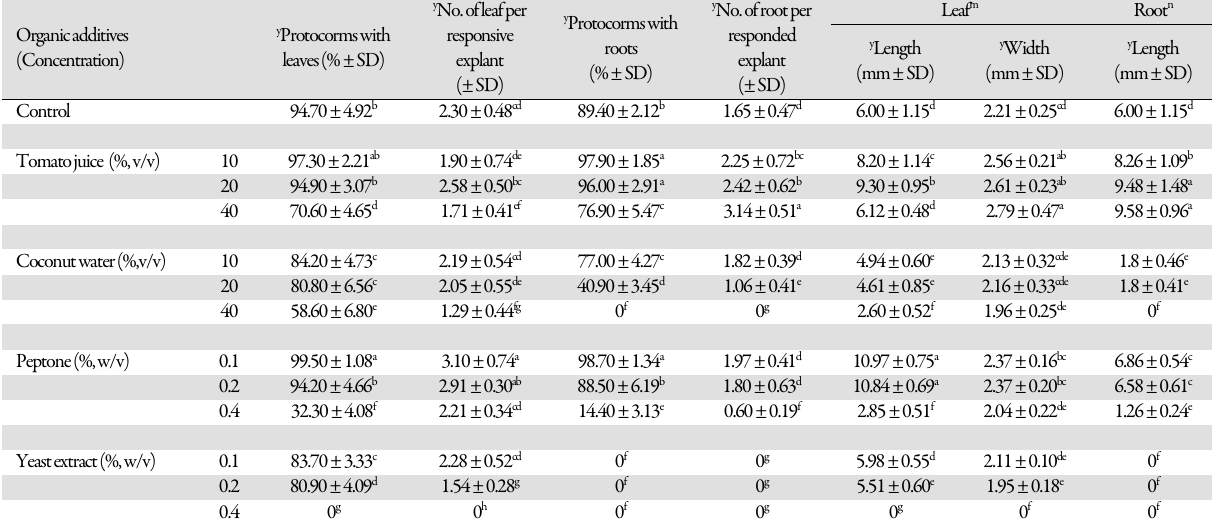
Table 3. Effect of organic additives on Vanda helvola seedlings development, after 90 days of culture on KC basal medium